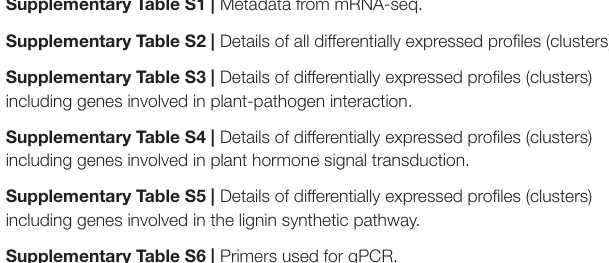
Supplementary Figure S1 | Phenotypes of resistant and susceptible species following inoculation with P. capsici ( A : Plants in the field; B : Stems; C : Leaves; D : Dry weight of roots). Supplementary Figure S2 | Detailed expression profiles of major lignin biosynthetic pathway genes in the roots of black pepper. Error bars denote the standard error from three biological replications. x-axis labels indicate treatment group and time point: CK, control; no prefix, inoculated with P. capsici ; numbers, hours post-infection. The y-axis represents gene expression level relative to that of ubiquitin. Each column represents the mean value plus standard deviation from three biological replicates. Supplementary Table S1 | Metadata from mRNA-seq. Supplementary Table S2 | Details of all differentially expressed profiles (clusters).